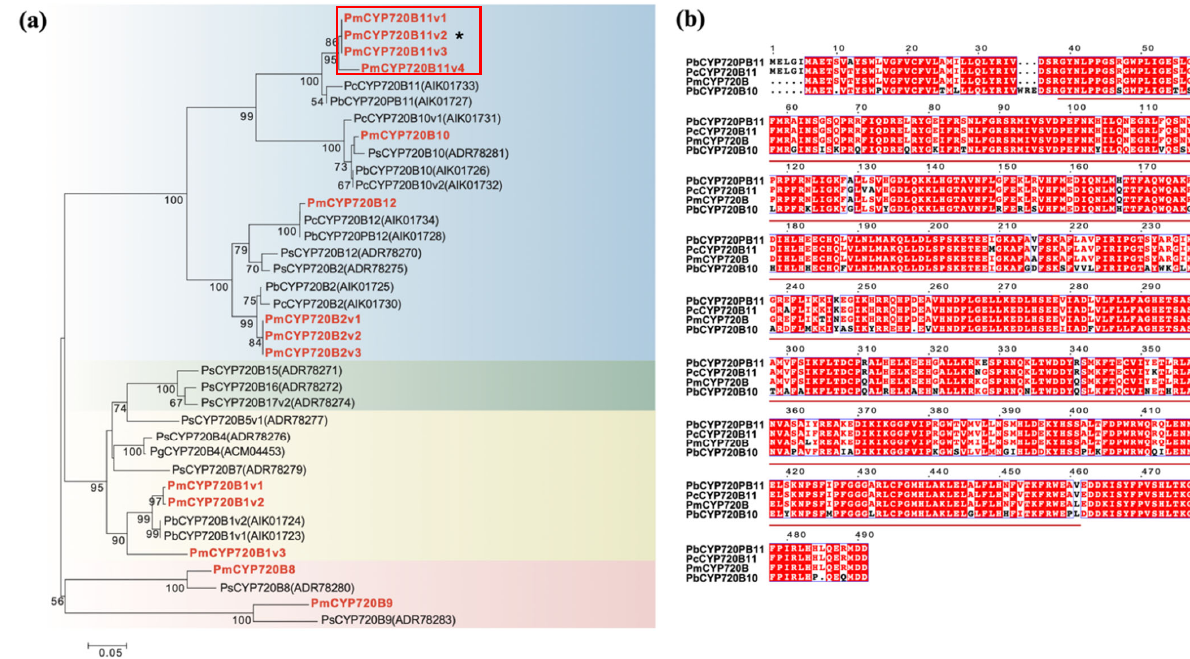
Figure 1. Phylogenetic analysis of CYP720Bs from P. massoniana. ( a ) Phylogenetic analysis of CYP720B enzymes from P. massoniana , P. contorta , P. banksiana , Picea sitchensis , and P. glauca . The maximum ‐ likelihood tree was obtained using the JTT method by CIPRES. Bootstrap values are shown as a percentage of 1000 replicates. The red fonts indicate PmCYP720Bs from P. massoniana . Asterisks (*) indicate the enzyme that was characterized in this study (PmCYP720B11v2). ( b ) Amino acid alignments of PmCYP720B11v2 from P. massoniana .